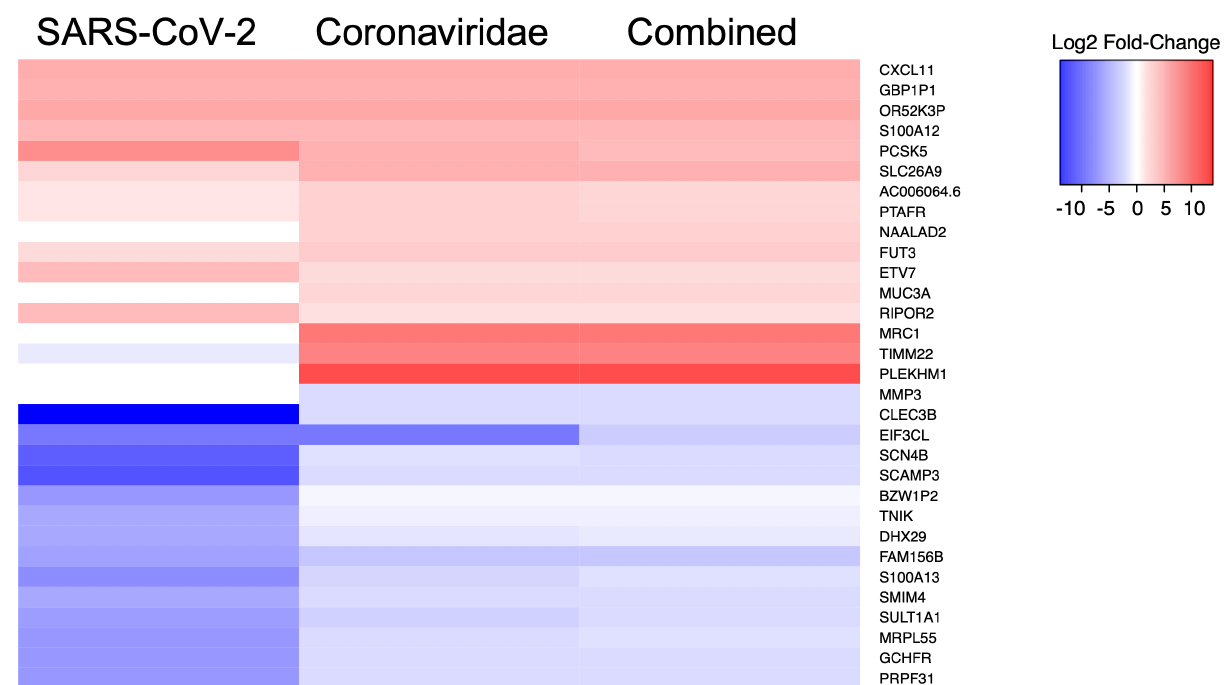
Figure 1. Heatmap of human transcriptional biomarkers associated with infection by various virus taxa. The five genes with the highest and lowest log2 fold-change values for each virus comparison were identified and compared against expression in the other datasets. Squares in red or blue represent genes that are upregulated or downregulated (respectively) in the relevant